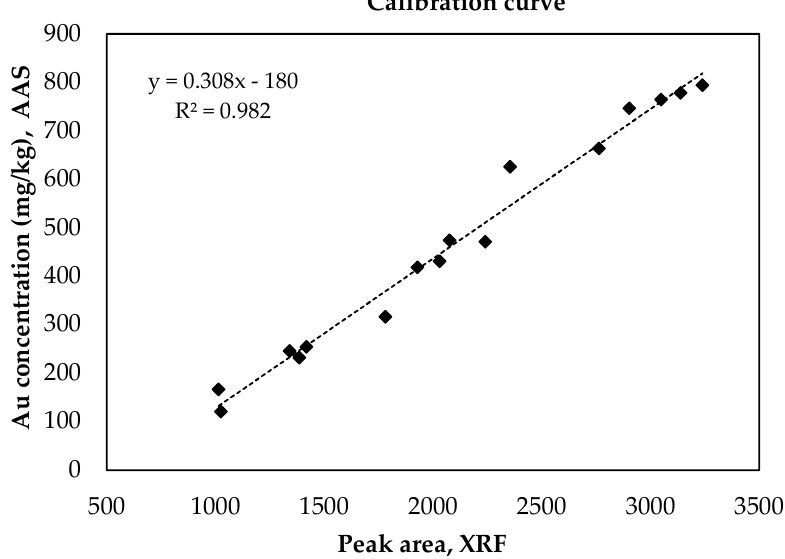
Figure 2. Calibration curve for FPXRF obtained by using real samples of PCBS as standards (number of standards: 16).